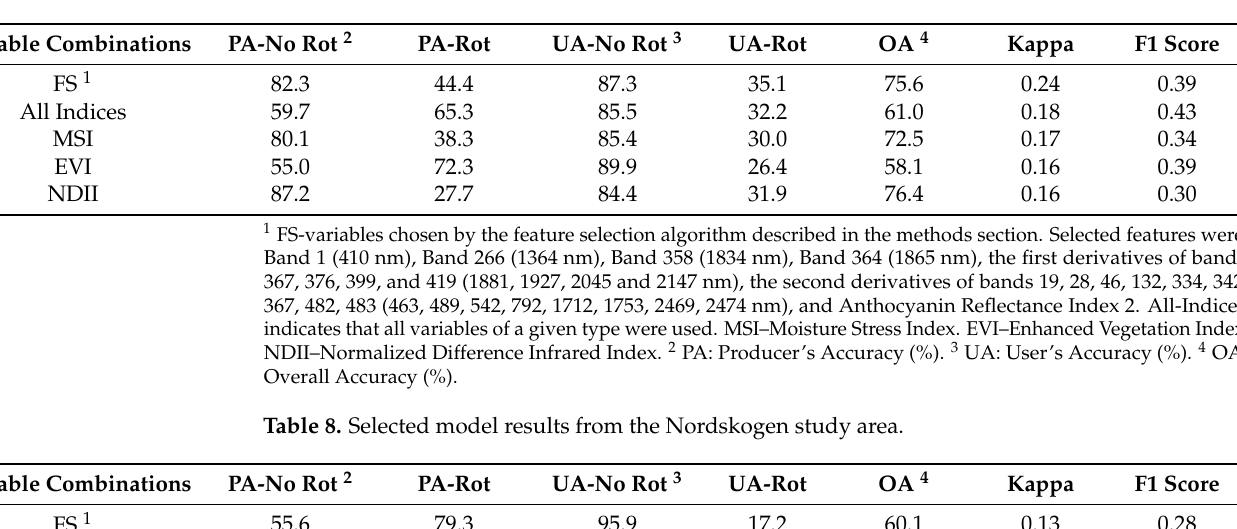
Table 7. Selected model results from the Etnedal study area.